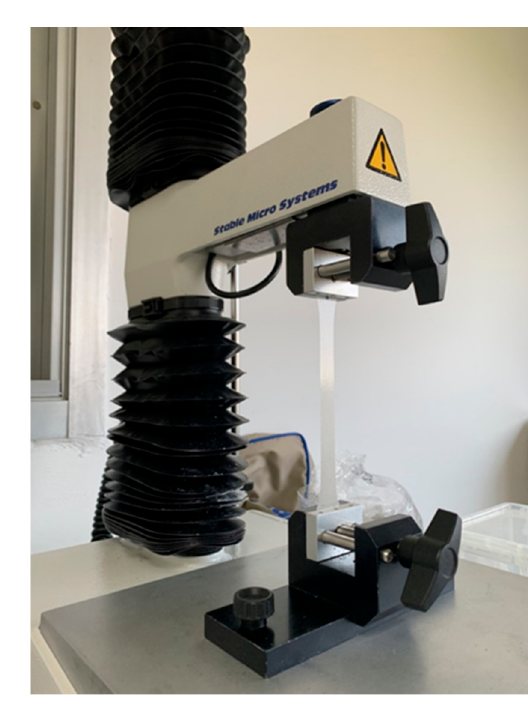
Figure 1. Flowchart of experimental design.